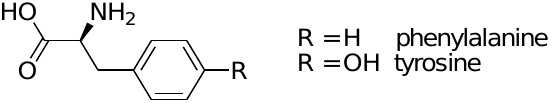
Figure 1. Chemical structure of Phe and Tyr aromatic amino acids.